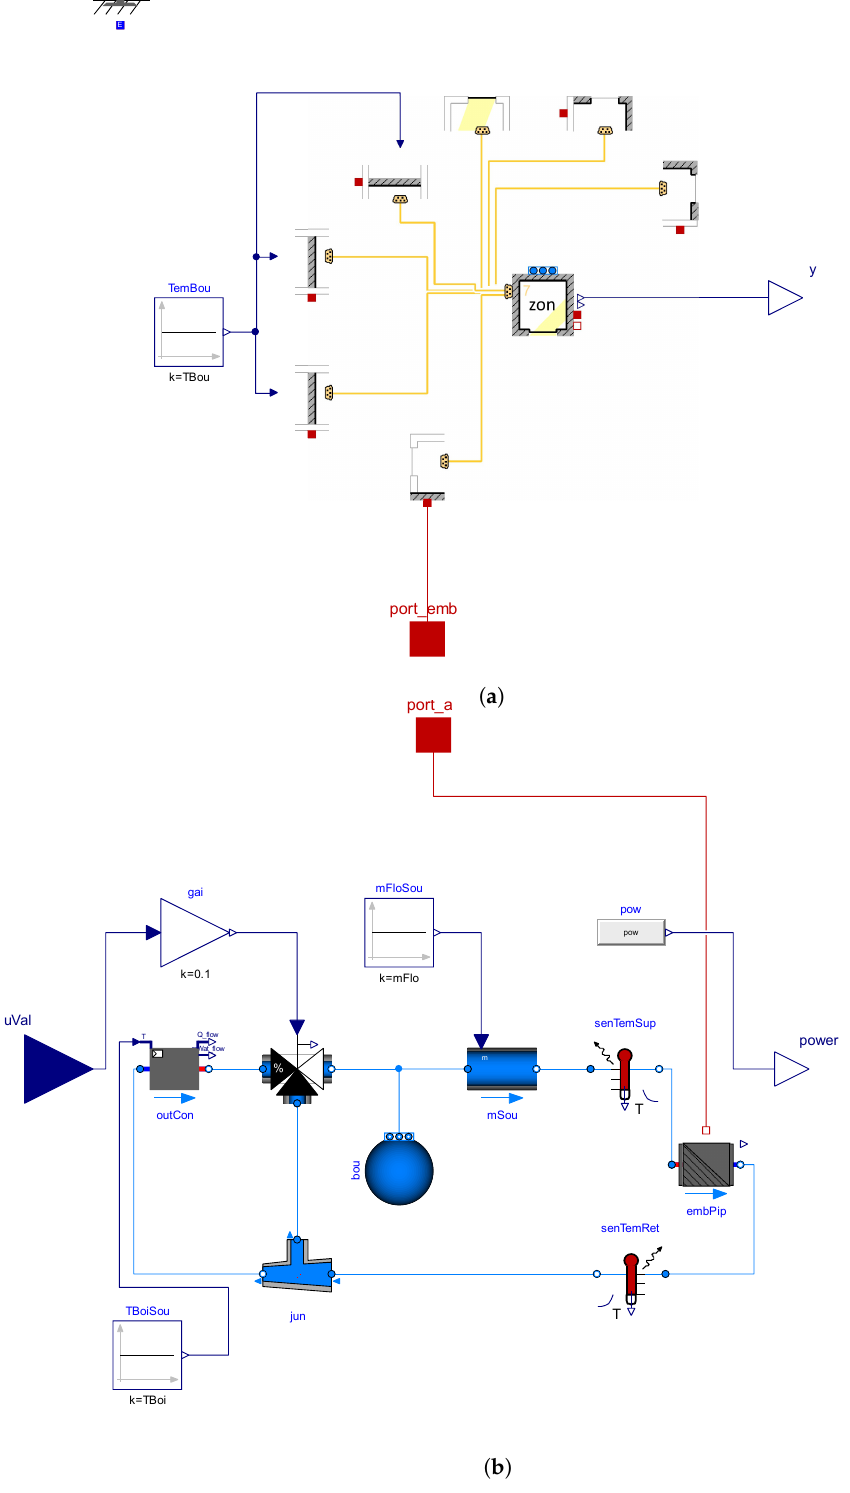
Figure A1. White-box model of the Vliet building test room and heating system. ( a ) White-box model of the building envelope of the test room; ( b ) White-box model of the heating